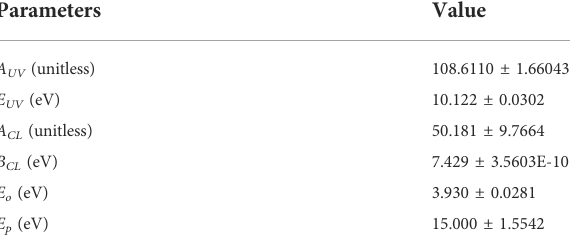
TABLE 1 Fitting parameters of Cody-Lorentz oscillator.